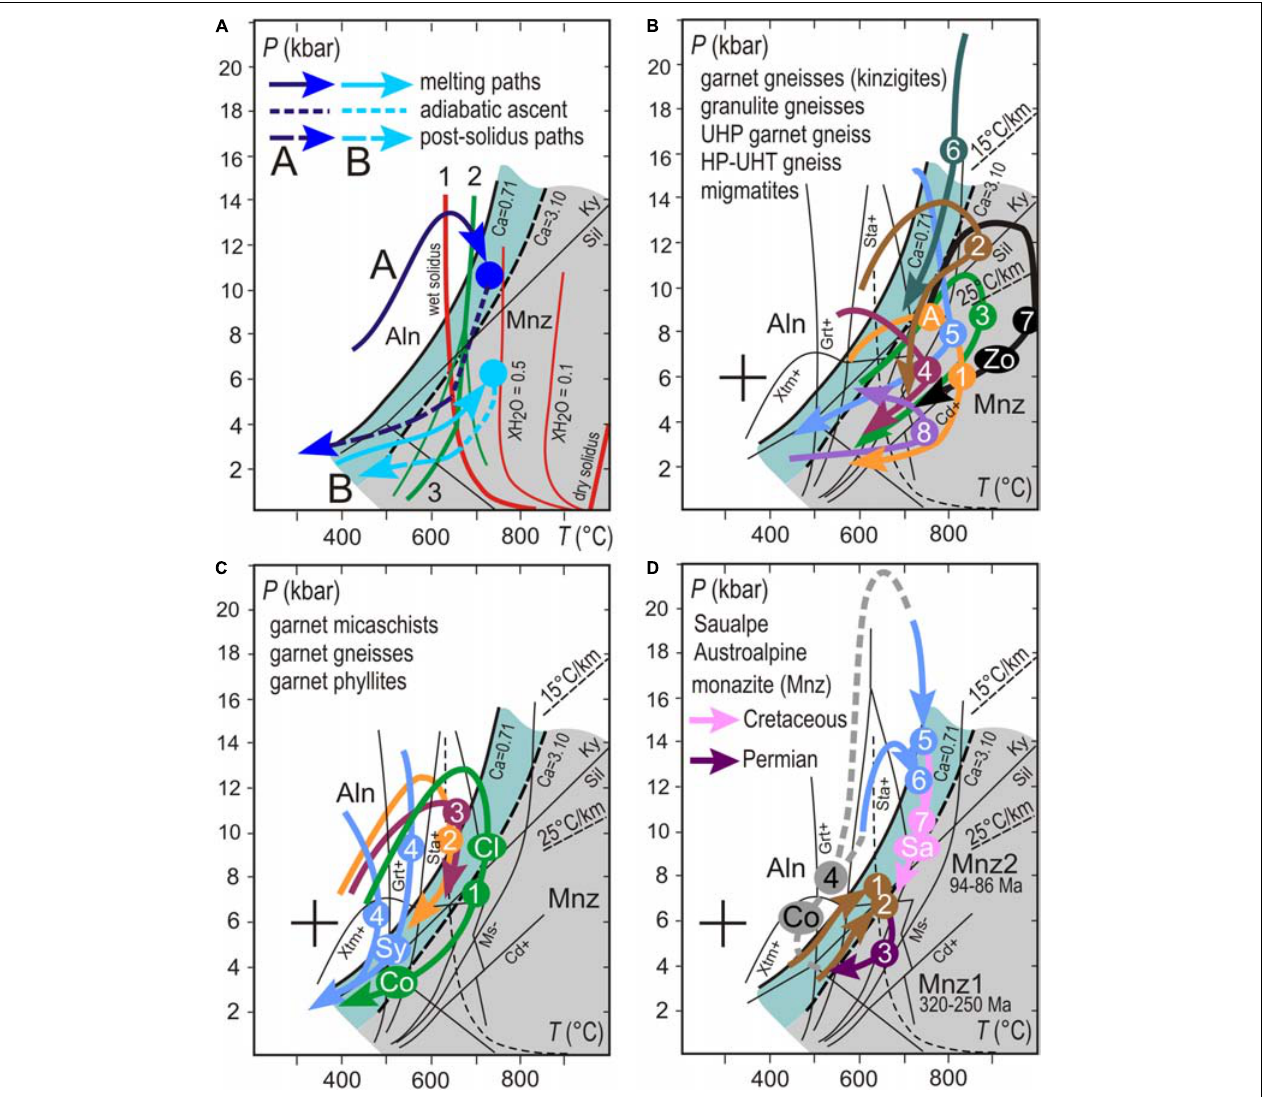
FIGURE 12 | Pressure-temperature evolution of monazite-bearing granites and P-T path reconstructions from metamorphic rocks. Characteristic monazite microstructures are indicated with abbreviations. Stability fields of monazite (Mnz) and allanite (Aln) at different bulk rock contents as a function of Ca wt%, and with the xenotime (Xtm) stability field after Janots et al. (2007) and Spear (2010). Petrogenetic grid for metapelites in the KFMASH system with major reactions in black lines are compiled from Spear (1993). Cross marks a general uncertainty of ± 50 ◦ C/1.0 kbar on geothermobarometric estimates. Red lines are solidus curves in the granitic system Qtz-Ab-Or-H 2 O at X H 2 O of 1.0 (curve 1), at X H 2 0 of 0.5 and 0.1 after Johannes and Holtz (1996). Green lines display the reaction Ms + Qtz + Pl = Ky + Kfs + melt (curve 2) and the muscovite-out reaction Ms + Qtz = Sill + Kfs + H 2 O at X H 2 O of 1.0 (curve 3) and at X H 2 O of 0.5 after Kerrick (1972). (A) Partial anatexis of crustal rocks (colored dots) by decompressional melting (path A) and low pressure melting (path B). Granitic melts underwent adiabatic ascent and crystallization. Melting path and post-solidus path A is mostly outside and at the margin of the monazite stability field. Major part of melting path and post-solidus path B is in the monazite stability field. (B) P-T paths of high-grade metamorphic rocks. 1 - cordierite garnet gneisses, Saxonian Granulite Massif (Schulz and Krause, 2018), with aggregation microstructure (A). 2 - kyanite garnet gneiss, Upper Gneiss Unit, French Massif Central (Schulz, 2014). 3 - cordierite garnet gneiss, Herbon Farm, Golfe de Morbihan, Southern Brittany (Schulz, 2013). 4 - hercynite cordierite garnet gneiss, Moldanubian Zone (Schulz, 2010). 5 - garnet gneisses, Léon Domain, Northern Brittany (Schulz et al., 2007). 6 - UHP garnet gneiss, Central Erzgebirge (Massonne, 2003). 7 - HP-UHT garnet biotite sillimanite granulite from Palni Hills, South India (Brandt et al., 2011), with monazite age and compositional zonation (Zo). 8 - counterclockwise P-T evolution in migmatites, SW New Hampshire (Pyle and Spear, 2003). (C) P-T paths of upper greenschist to amphibolite facies rocks with monazite and garnet. 1 - Oetztal-Stubai Basement (Schulz et al., 2019b), with cluster (Cl) and corona structures (Co). 2 - Lower Unit, Münchberg Nappe, Saxothuringian Zone (Schulz et al., 2017). 3 - North Patagonian Basement in Argentina (Oriolo et al., 2019). 4 - Phyllite and micaschist units of the Western Erzgebirge (Mingram and Rötzler, 1999; Willner et al., 2000), with symplectite structure (Sy). (D) Case study of monazite crystallization and decomposition during polyphase metamorphism of Austroalpine Saualpe basement (Schulz, 2017). 1, 2 - garnet 1 crystallization in the Eclogite and Preims nappe units. 3 - Permian monazite 1 (Mnz1) crystallized during intrusion of numerous pegmatites. 4 - inferred retrogressive and compression path between garnet 1 and garnet 2 crystallization, with corona structures (Co) around Permian monazites. 5, 6 - garnet 2 crystallization in the Eclogite and Preims nappe units. 7 - Cretaceous monazite 2 (Mnz2) crystallization during decompression, partly in satellite structures